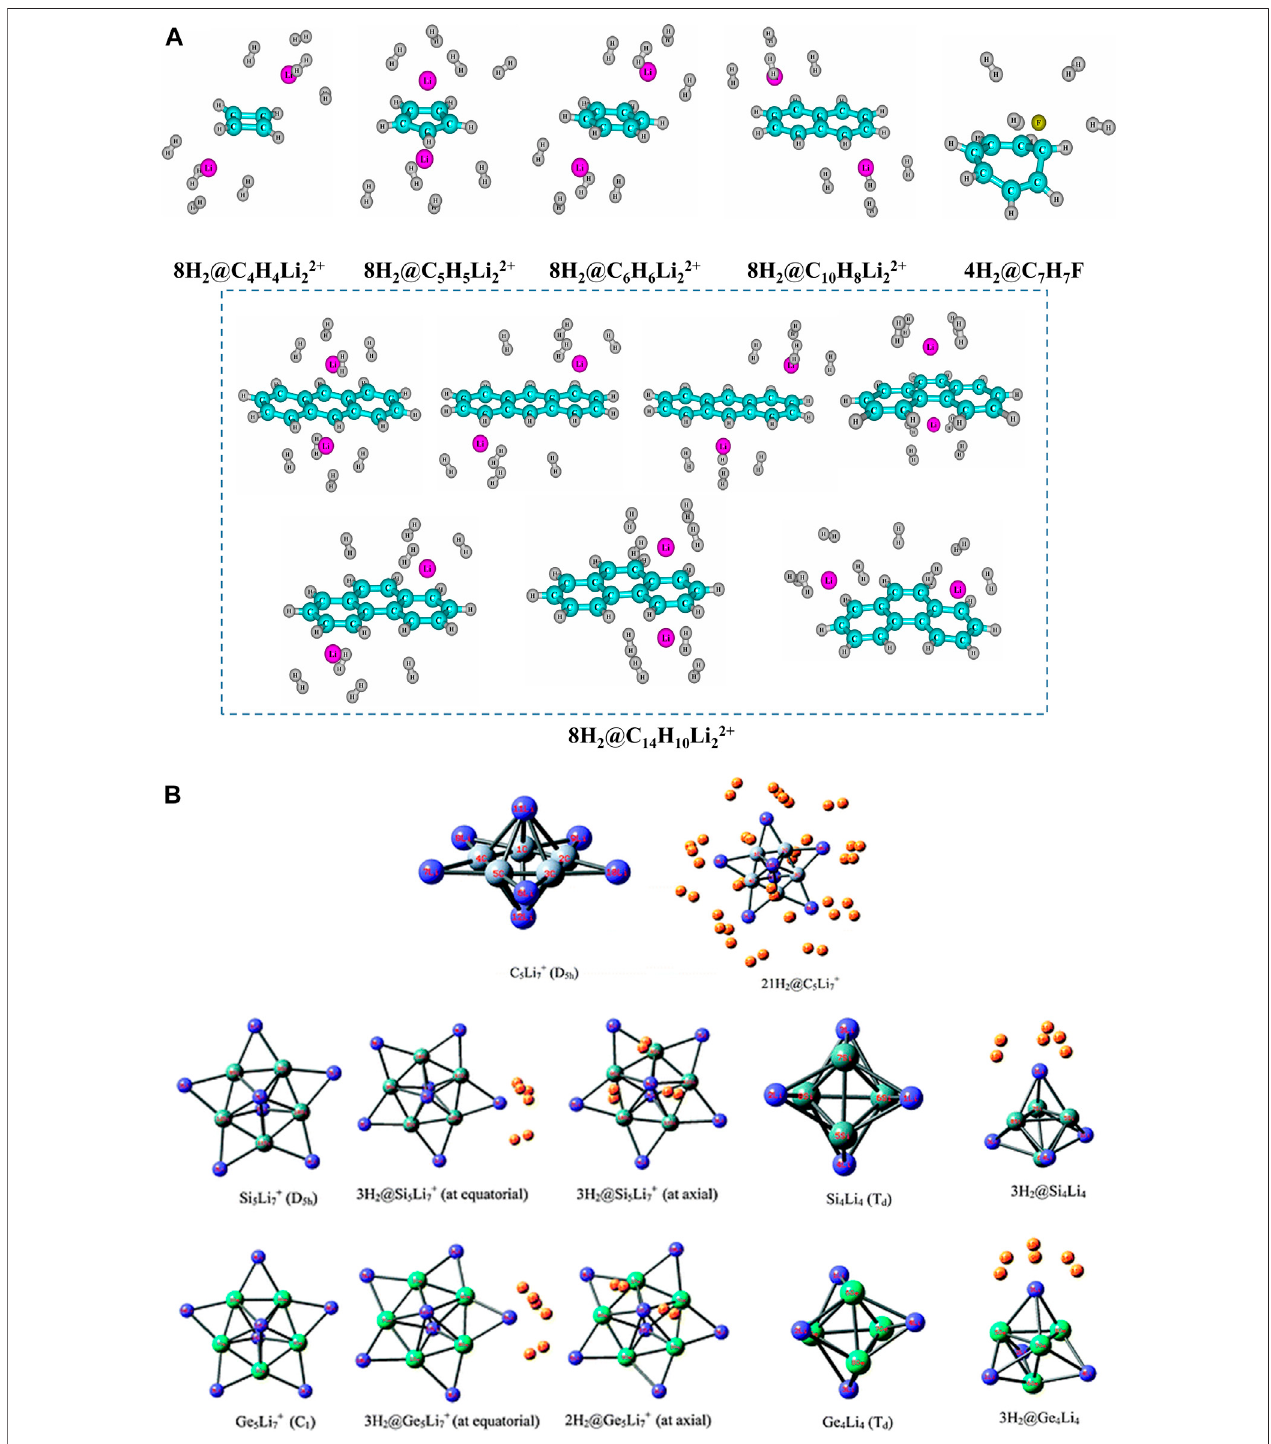
FIGURE 6 | Optimized geometries of (A) maximum H 2 -loaded Li + /F − -doped annular systems, (B) 3D molecular star-like systems, C 5 Li 7 + and its Si and Ge analogues (Reproduced from (A) Giri et al., 2011c, and (B) Pan et al., 2012 with permission from the PCCP Owner Societies).